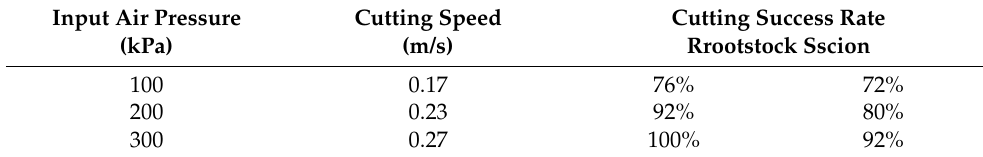
Table 2. Influence of cutting speed on cutting success